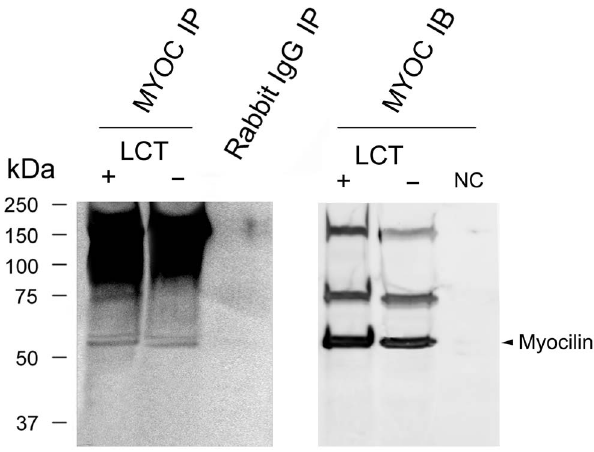
Figure 3. Myocilin is ubiquitinated. Total lysates from normal human TM cells without or with the LCT treatment were immunopre- cipitated (IP) with rabbit anti-myocilin polyclonal antibody or normal rabbit IgG (as a negative control, NC) followed by immunoblotting (IB) with mouse anti-ubiquitin monoclonal antibody. Myocilin pull down by rabbit anti-myocilin (MYOC), but not the rabbit IgG control, showed multiple bands immunoreactive to anti-ubiquitin (left panel). The intensity of the ubiquitin-positive bands was enhanced by prior LCT treatment. The same blot was also probed with anti-myocilin (right panel) to verify the IP procedure. Arrow head, the 55/57-kDa myocilin bands.